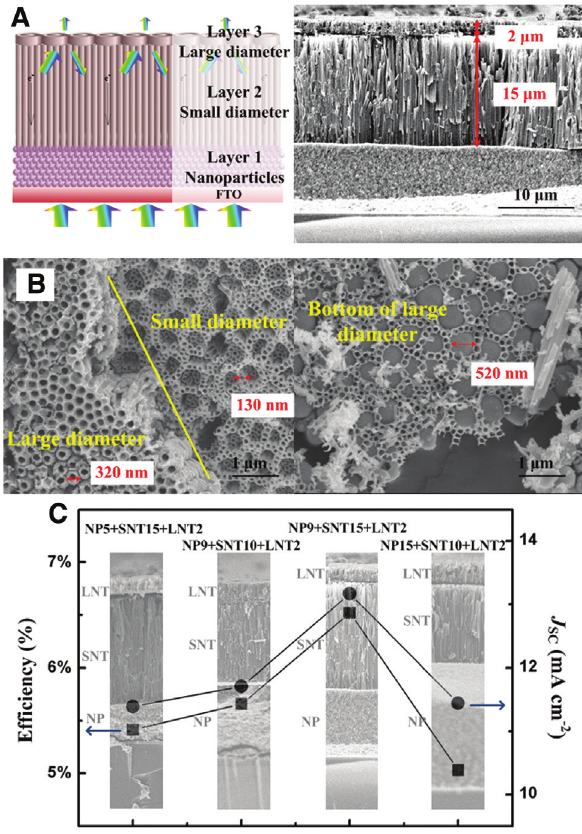
Figure 6 (A) The schematic drawing (left) and the cross-sectional SEM image (right) of the multi-layered photoanode. From bottom to top: FTO glass substrate; layer 1 is NPs; layer 2 is SNTs; layer 3 is LNTs. The incident sunlight enters the solar cell from the bottom side. The thicknesses of layers 1, 2 and 3 are about 9, 15 and 2 μ m, respectively. (B) The SEM images showing the morphologies of the top of SNTs and LNTs and the bottom of LNTs (with remnant of SNTs). The diameters of large tubes at the top and bottom are about 320 and 520 nm, respectively. That is to say, the diameters from top to bottom are not uniform, with a “tapered” NT morphology. And the diameter of small tubes is about 130 nm. (C) The depend- ence of the solar cell efficiency on the thickness of each